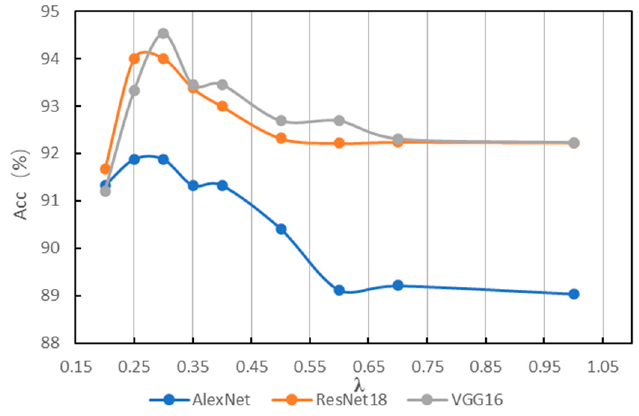
Figure 6. Results of different λ on MFPT. Table 3. Results of different λ on JNU.